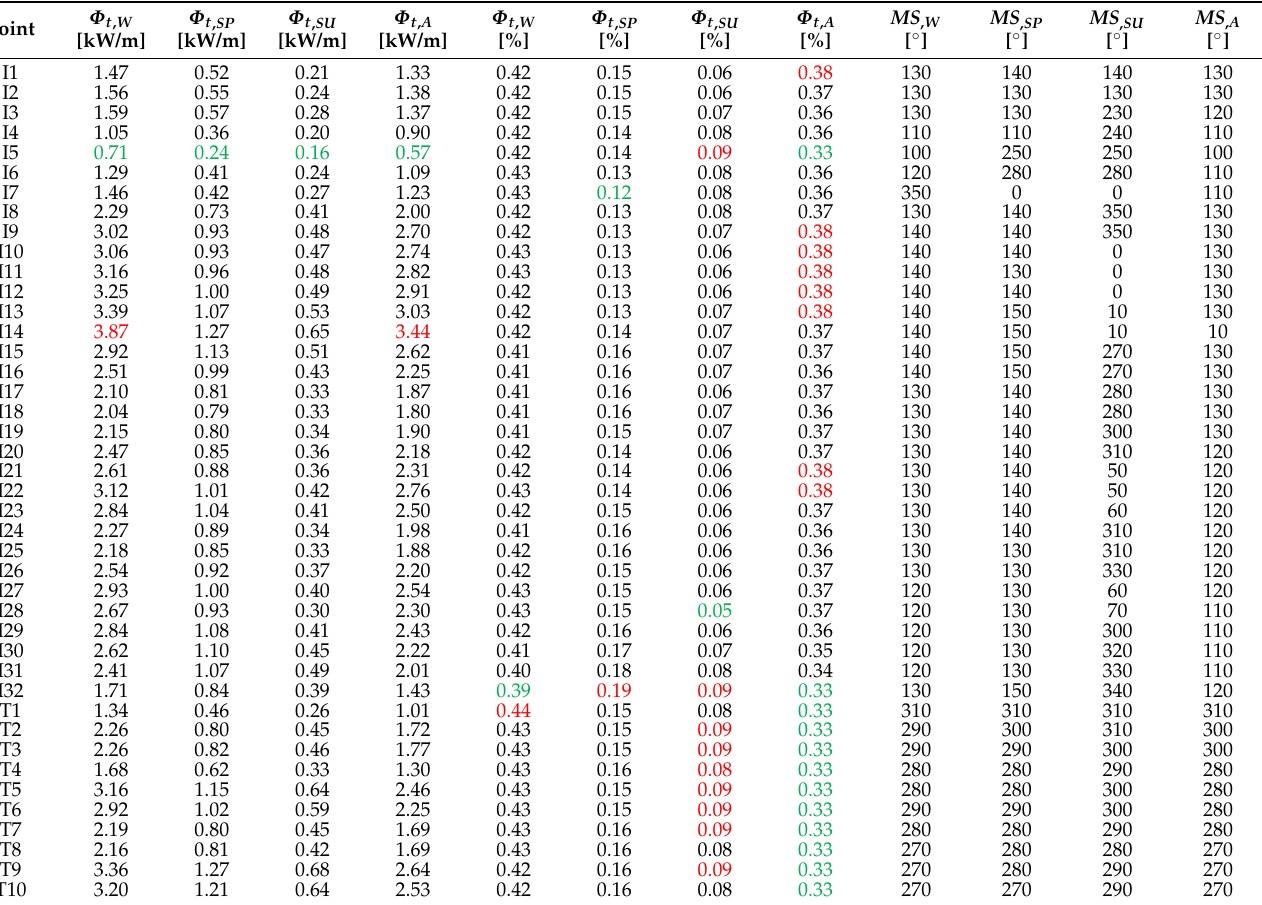
Table 4. Values of seasonal average annual energy flux Φ t , i , and of seasonal main sector MS i , where the i-th season has been indicated with subscripts W for winter, SP for spring, SU for summer and A for autumn. Legend: the higher values are in red, and the lower values are in